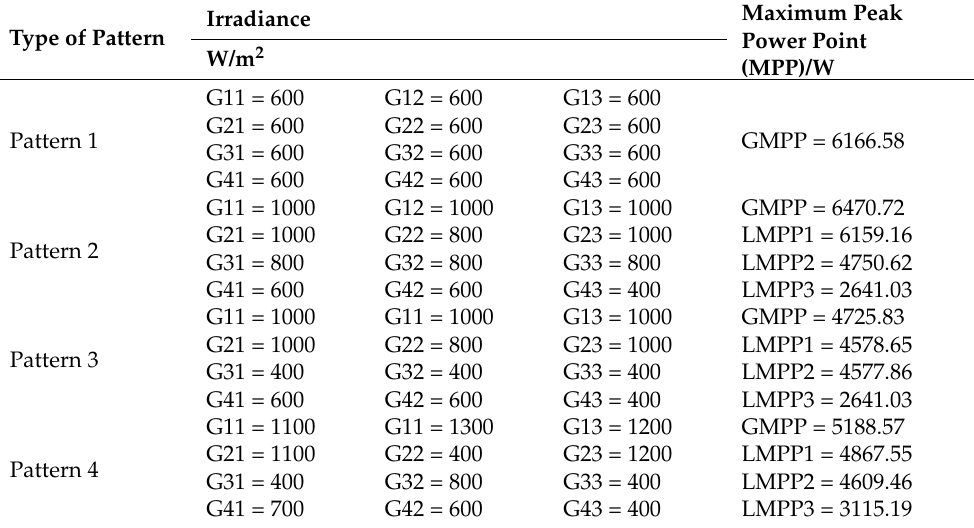
Table 4. Photovoltaic array irradiance